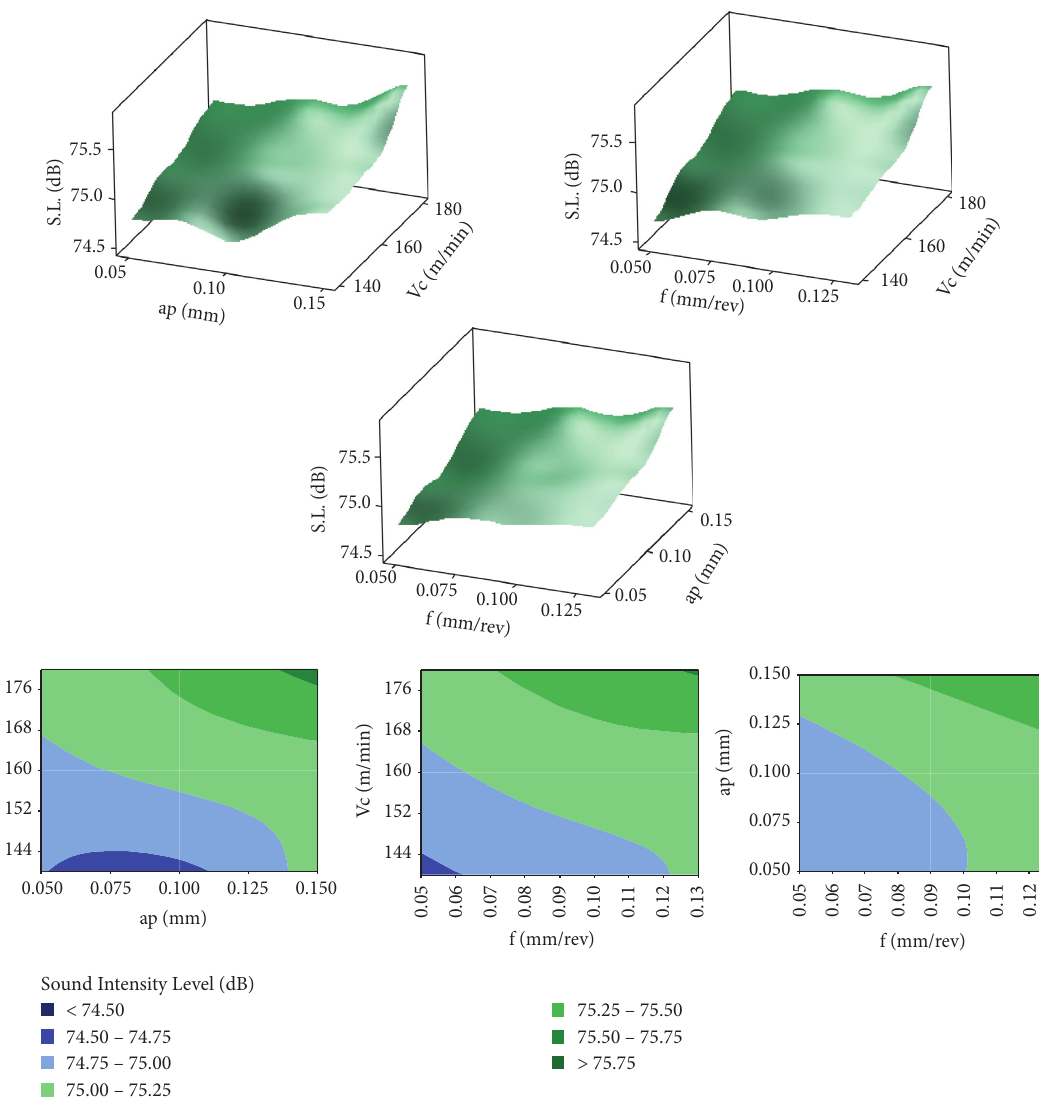
Figure 5: 3D surface plots and contour plots based on cutting parameters for sound intensity